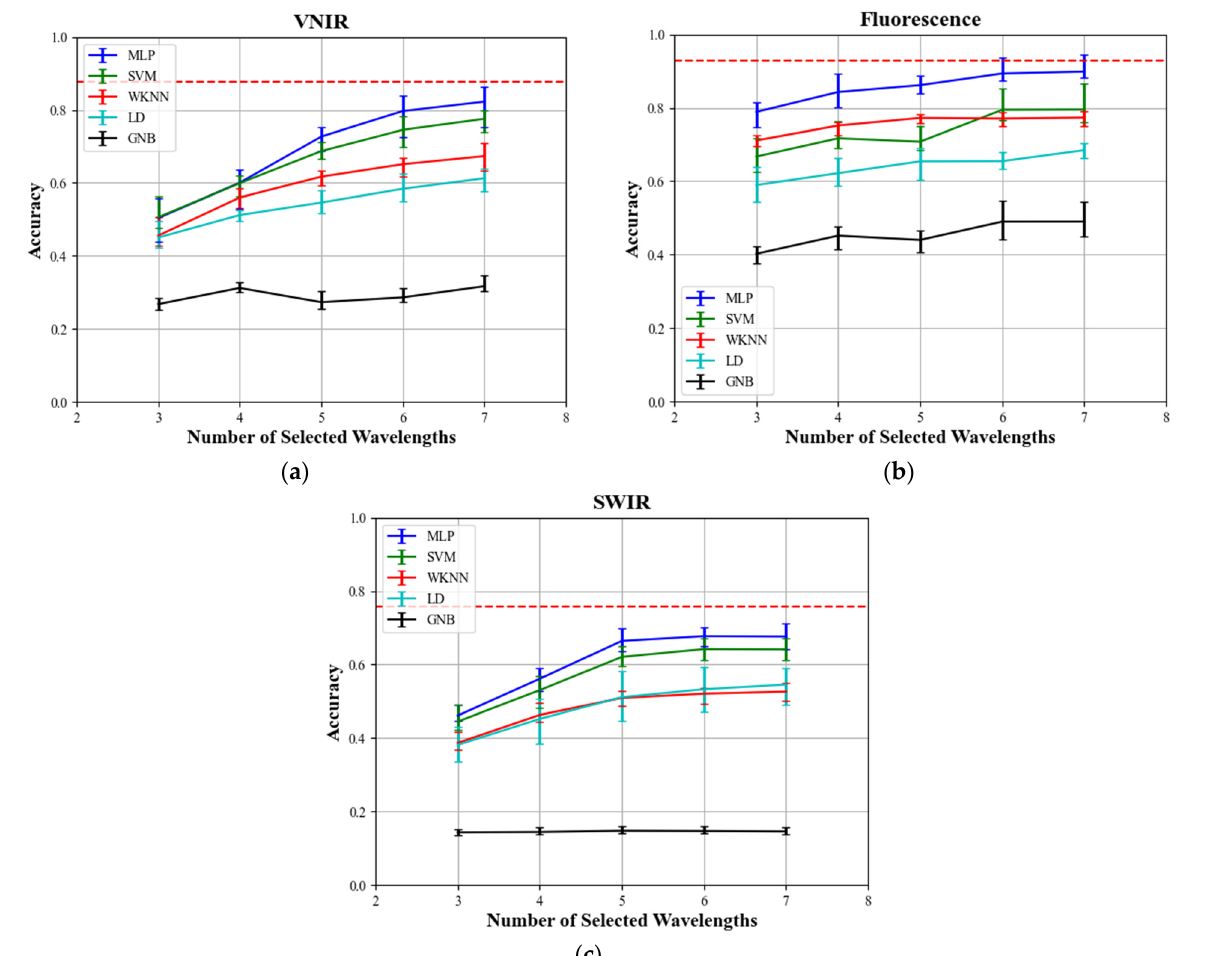
Figure 13. Plot of 4-fold cross-validation accuracies for each of the five classifiers as a function of the number of selected wavelengths in the single-mode classification study for ( a ) VNIR, ( b ) fluorescence, and ( c ) SWIR data. The red dashed line in each plot marks the benchmark accuracy obtained by MLP using all wavelength in the spectrum. Error bars mark the range of accuracies for the four folds.